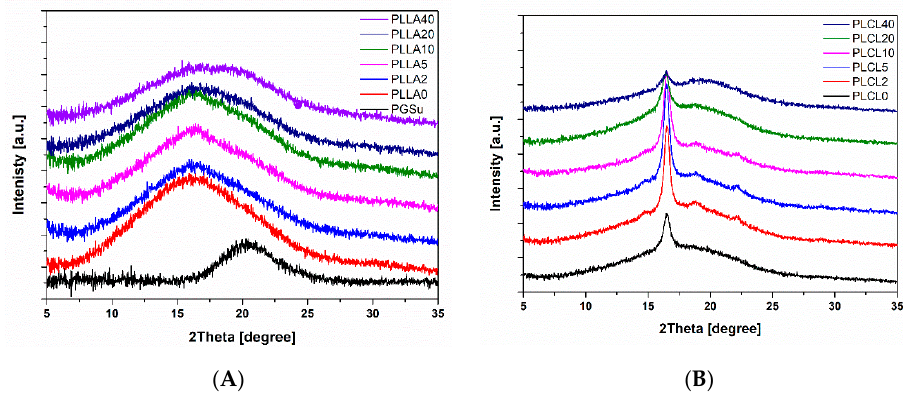
Figure 6. Wide angle X-ray scattering (WAXS) spectra of electrospun bicomponent fibres with PGSu additive: ( A ) PLLA2, PLLA5, PLLA10, PLLA20, and PLLA40 in relation to PLLA0 (pure PLLA);